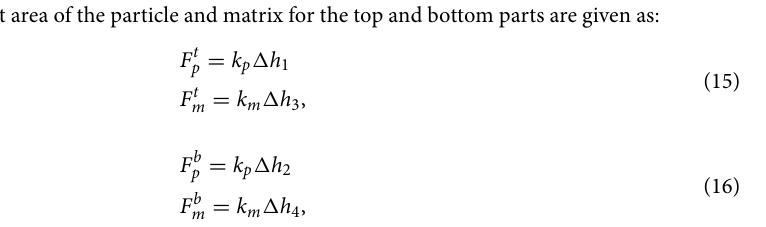
(S.3). These form a system of 17 coupled, nonlinear differential equations (note that each of Eqs. (4)–(6), (8), (9), (15), (16) represents one equation for the top and one for the bottom segments of the model) for F t vdw , F t H , F t p ,